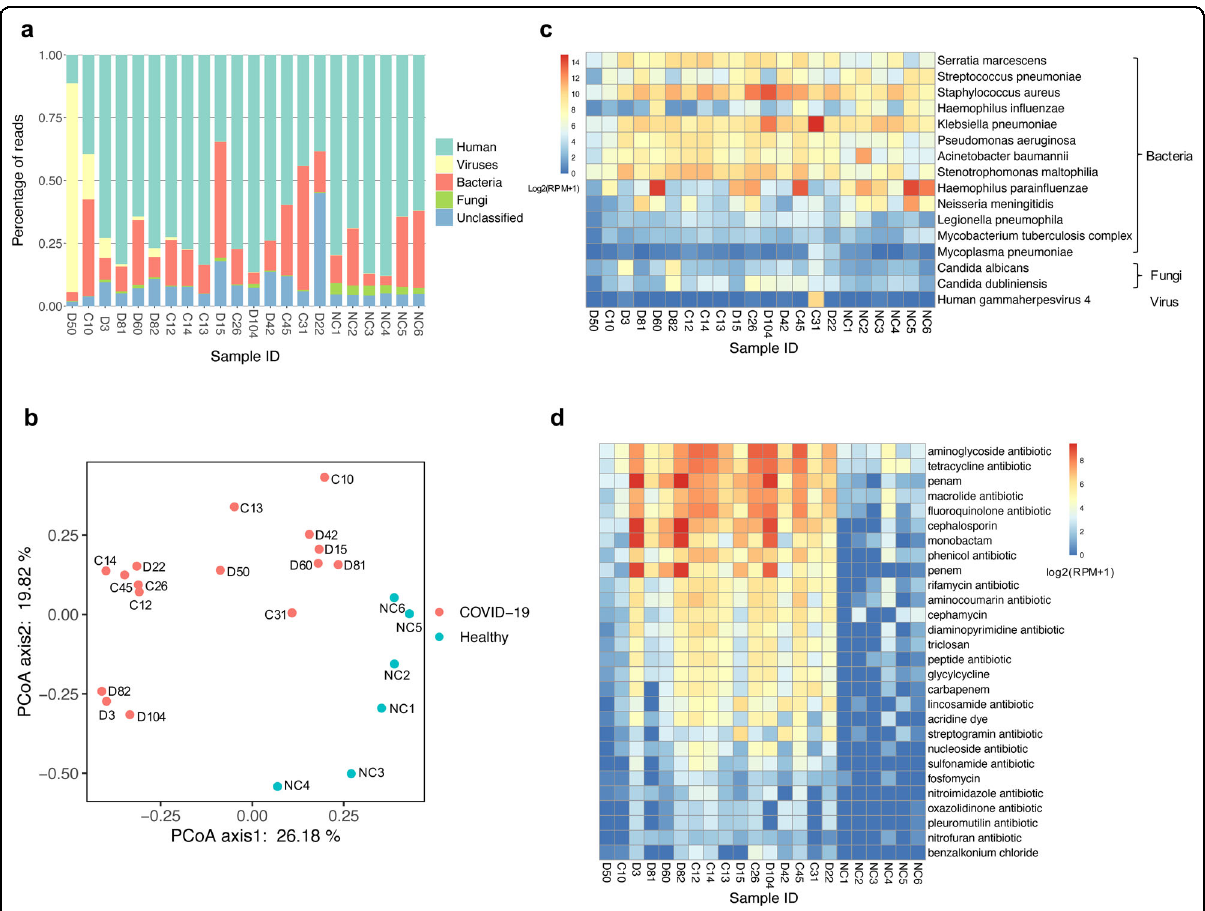
Fig. 3 Microbiome pro fi les in COVID-19 patients and healthy individuals. a Histogram showing percentage of reads mapping to human, viruses, bacteria, and fungi for the individual samples. b PCoA of microbiome using relative abundance at the genus level. c Heatmap showing relative abundance of potential respiratory pathogens identi fi ed in SARS-CoV-2-positive and -negative samples. RPM, reads per million non-host reads. d Heatmap displaying relative abundance of antibiotic resistance genes in SARS-CoV-2-positive and -negative